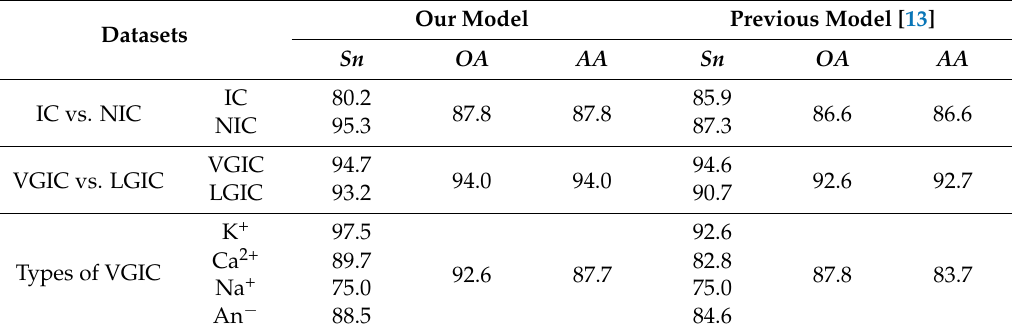
Table 2. Performance evaluation parameters of our proposed model and a previous model.